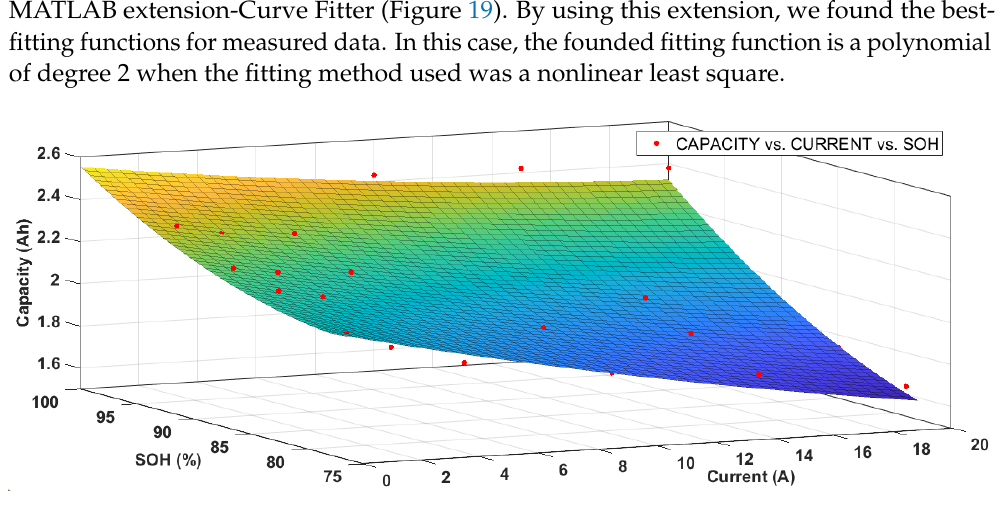
Figure 19. Fitted date based on measurements from Table